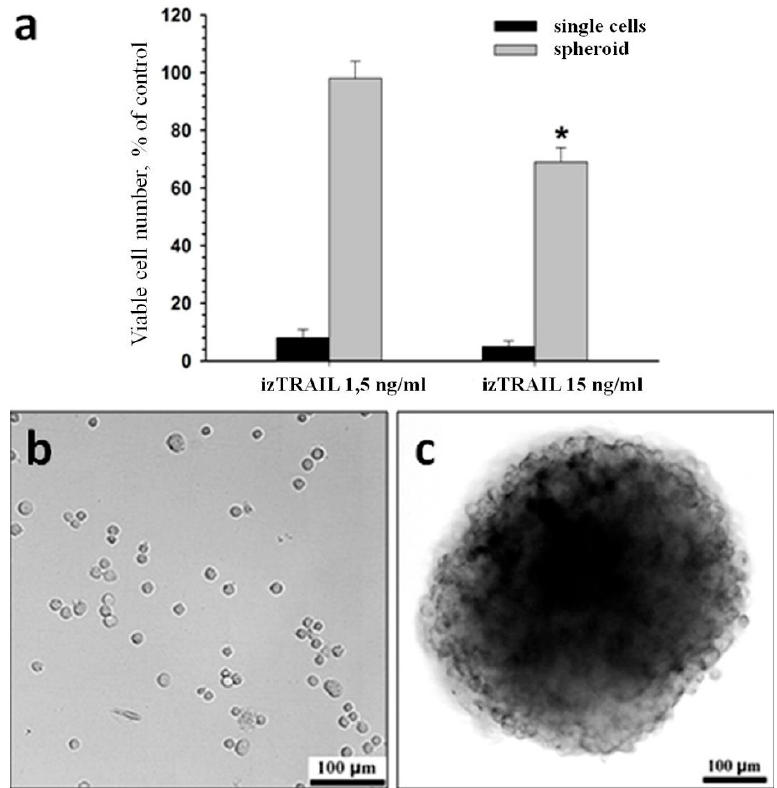
Figure 3. Increase in izTRAIL resistance of HT-1080 cells in spheroids. ( a ) Cell viability in spheroids or cell culture one day after the addition of izTRAIL immediately after seeding, n = 5. ( b ) representative images of cell culture after seeding; ( c ) a typical spheroid. * p < 0.05. Int. J. Mol. Sci. 2018 , 19 , x FOR PEER REVIEW Sorafenib suppresses the multicellular TRAIL resistance of HT-1080 cells in spheroids. For